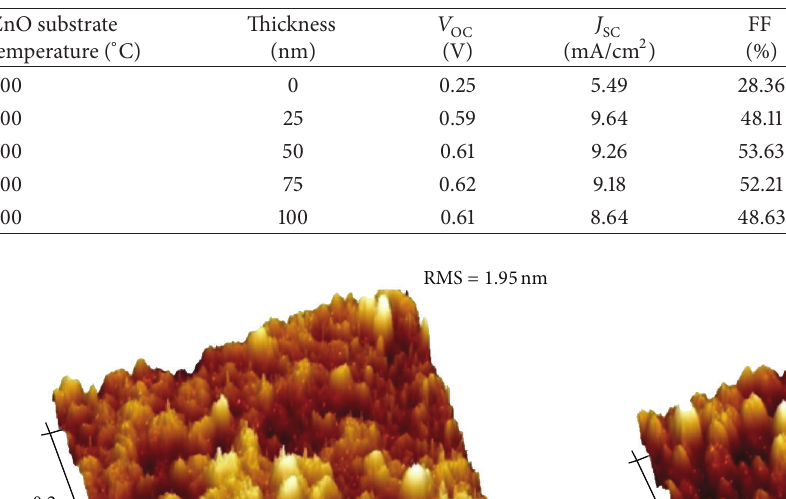
Table 2: Device characteristics of PSCs prepared at different substrate temperatures.